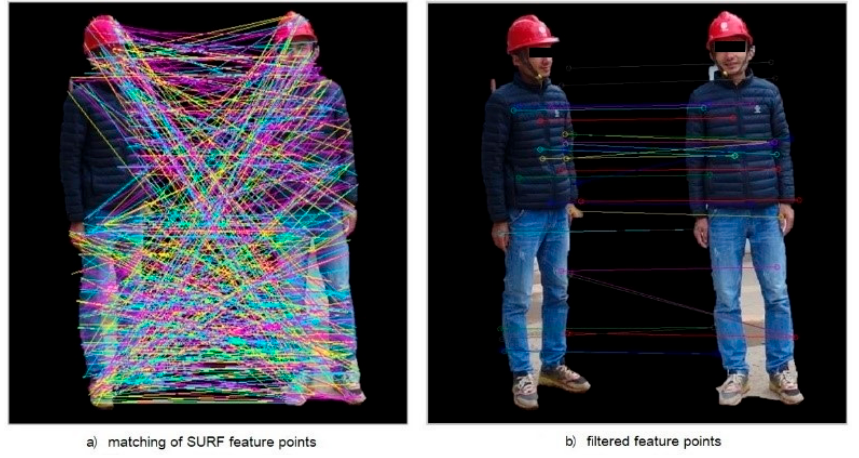
Figure 11. SURF feature point matching.